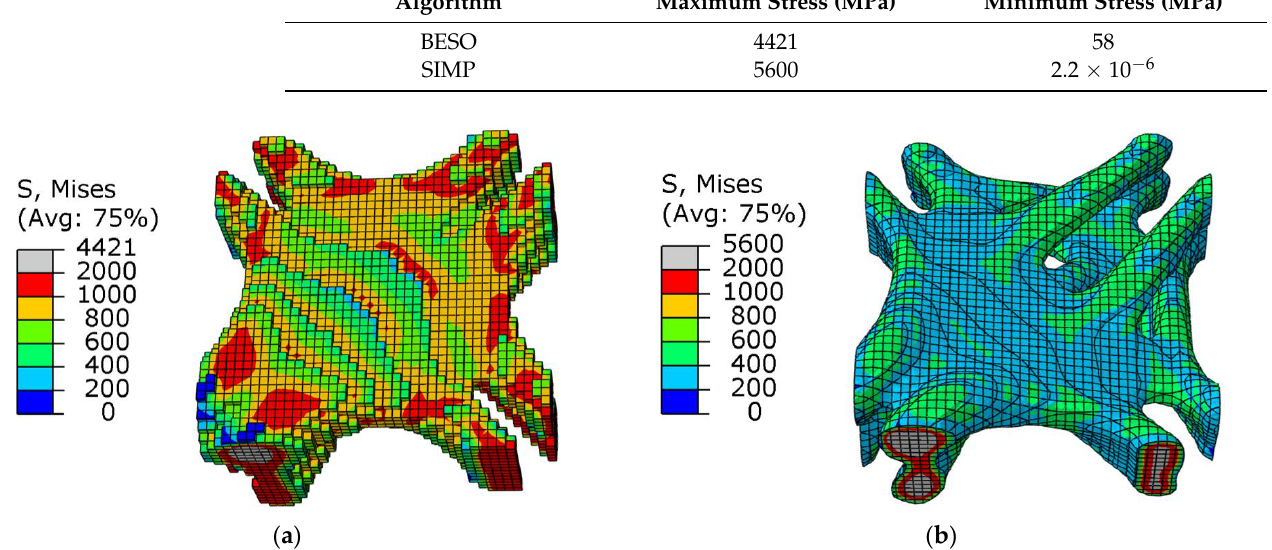
Figure 16. Stress cloud diagram in the design domain of optimized joints under combined conditions: ( a ) BESO; ( b ) SIMP.